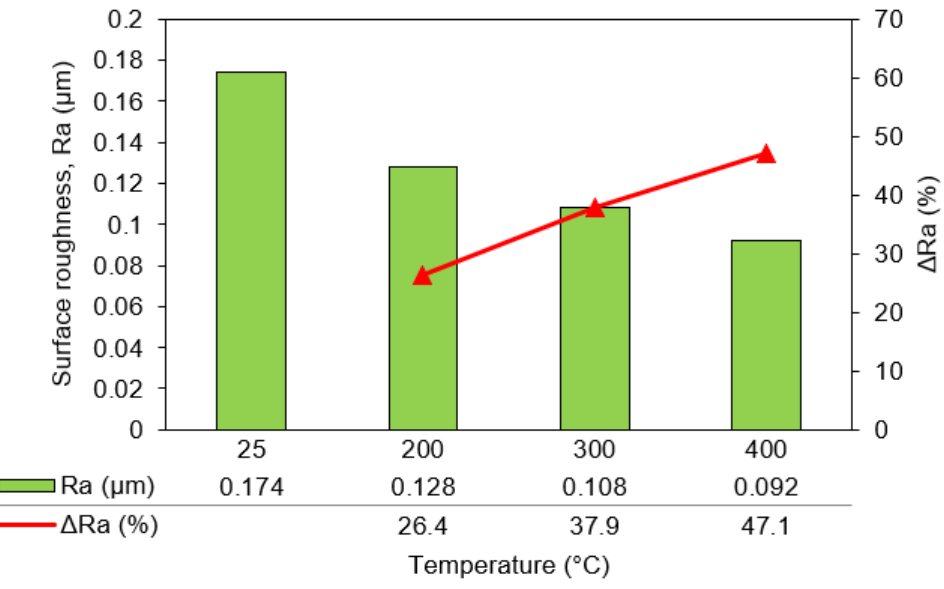
Figure 10. Surface Roughness and Reduction at Elevated Machining Temperatures.